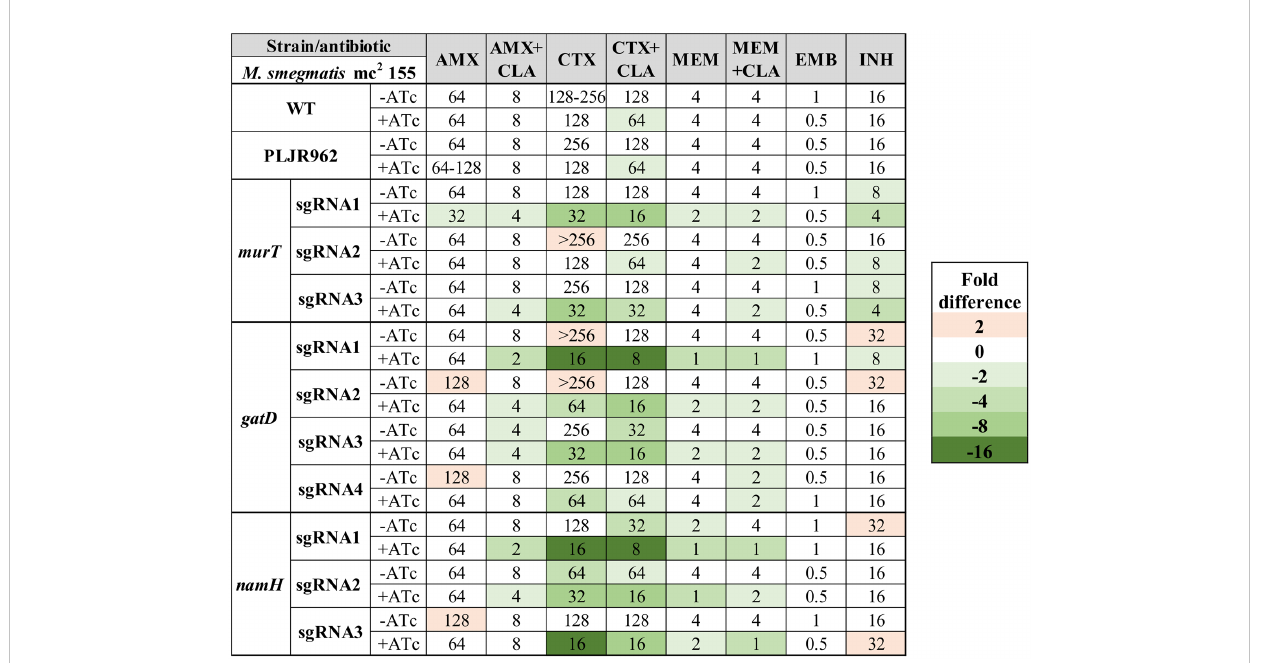
FIGURE 6 Heatmap of the fold differences in minimum inhibitory concentrations (MICs) of the knockdown mutants constructed in the M. smegmatis WT strain, with and without ATc. Columns represent the antibiotics and rows represent the strains. The median MIC (in µg/mL) of each antibiotic for each strain is shown in the respective intersection and colours depict an increase (red shades) or decrease (green shades) in the value when compared to the MICs of M. smegmatis WT. AMX, amoxicillin; CLA, clavulanate; CTX, cefotaxime; EMB, ethambutol; INH, isoniazid; MEM,